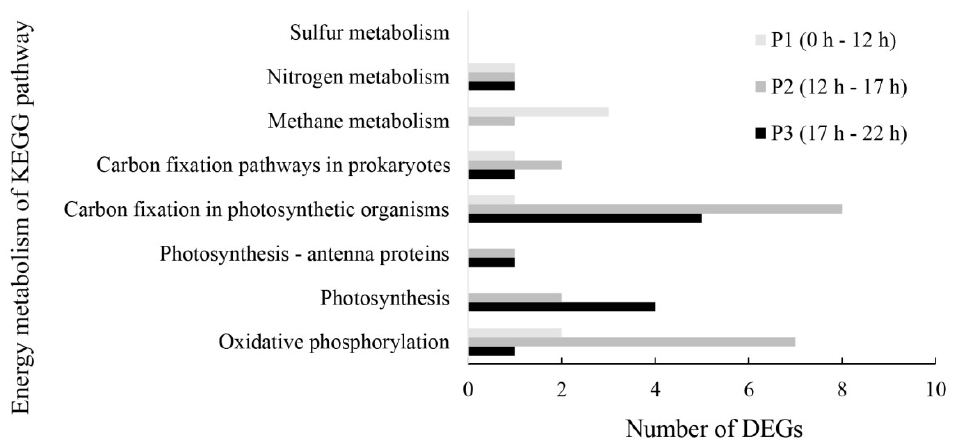
Figure 4. Number of differential expression genes involved in energy metabolism after pair-wise comparison.